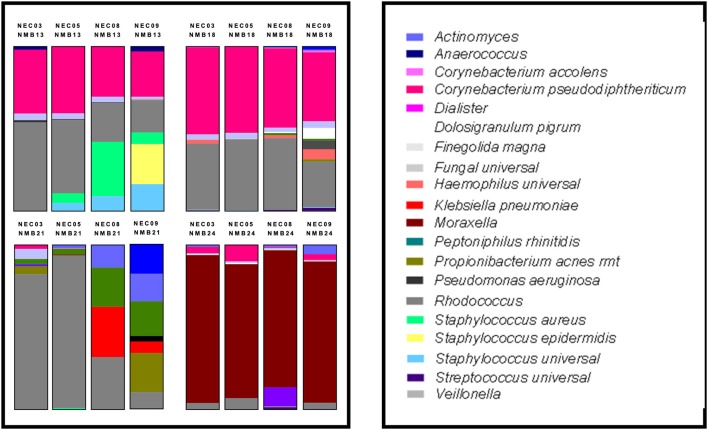
Human NMB colonization of 4 NEC ALI cultures. Selected NMB inocula were transplanted onto the apical surfaces of 4 distinct NEC cultures to examine differences in colonization capacity. For these studies a single cryopreserved aliquot of NMB was prepared and used to inoculate each of the NEC in parallel. These analyses revealed that the NEC09 microenvironment led to the greatest variance in community profile relative to the other cultures. Each profile represents the average of triplicate wells created in parallel. The study was repeated with indistinguishable results.